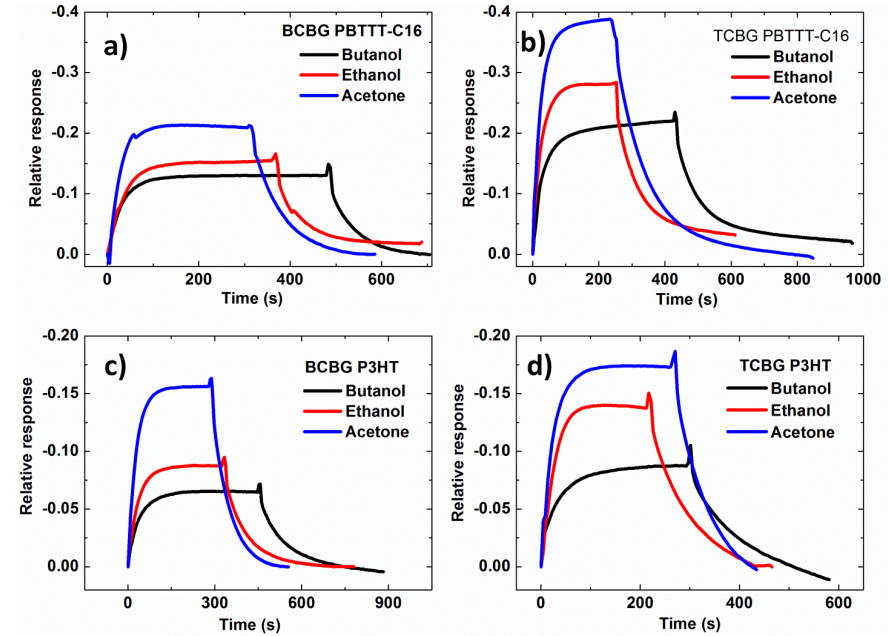
= 0.5 at ‒6.6 °C). ( a ) TCBG s